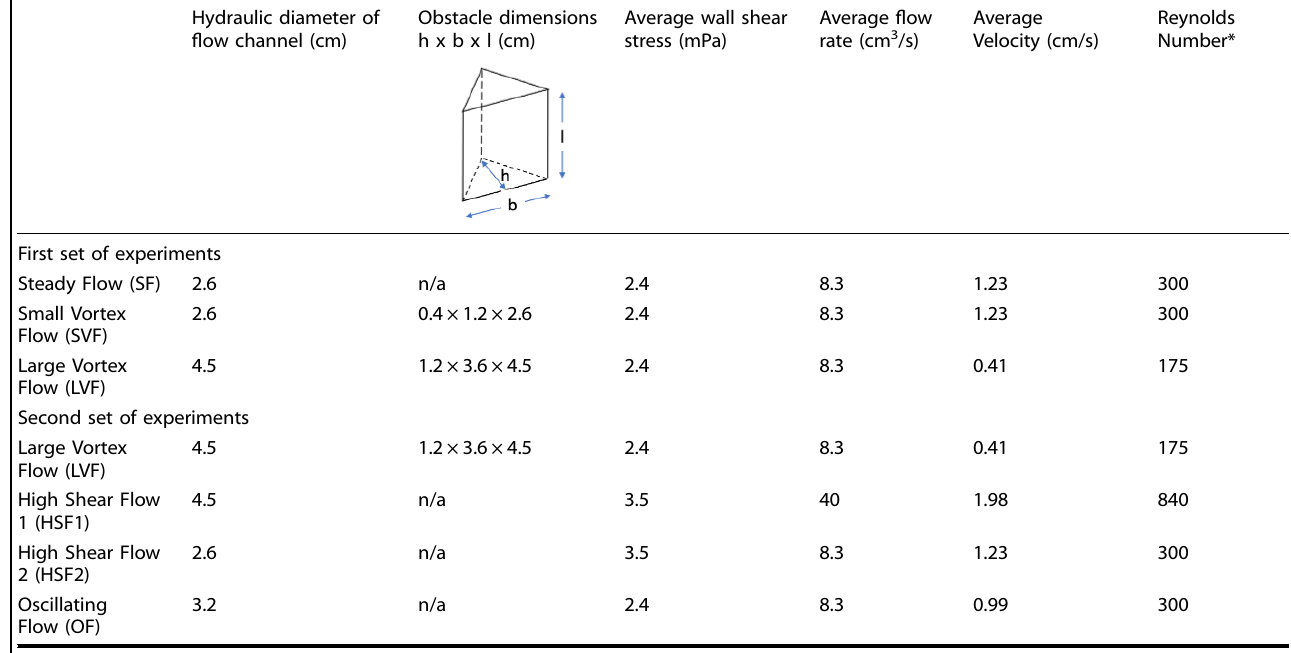
Table 1. The dimensions and characteristics of the fl ow in each of the fl ow